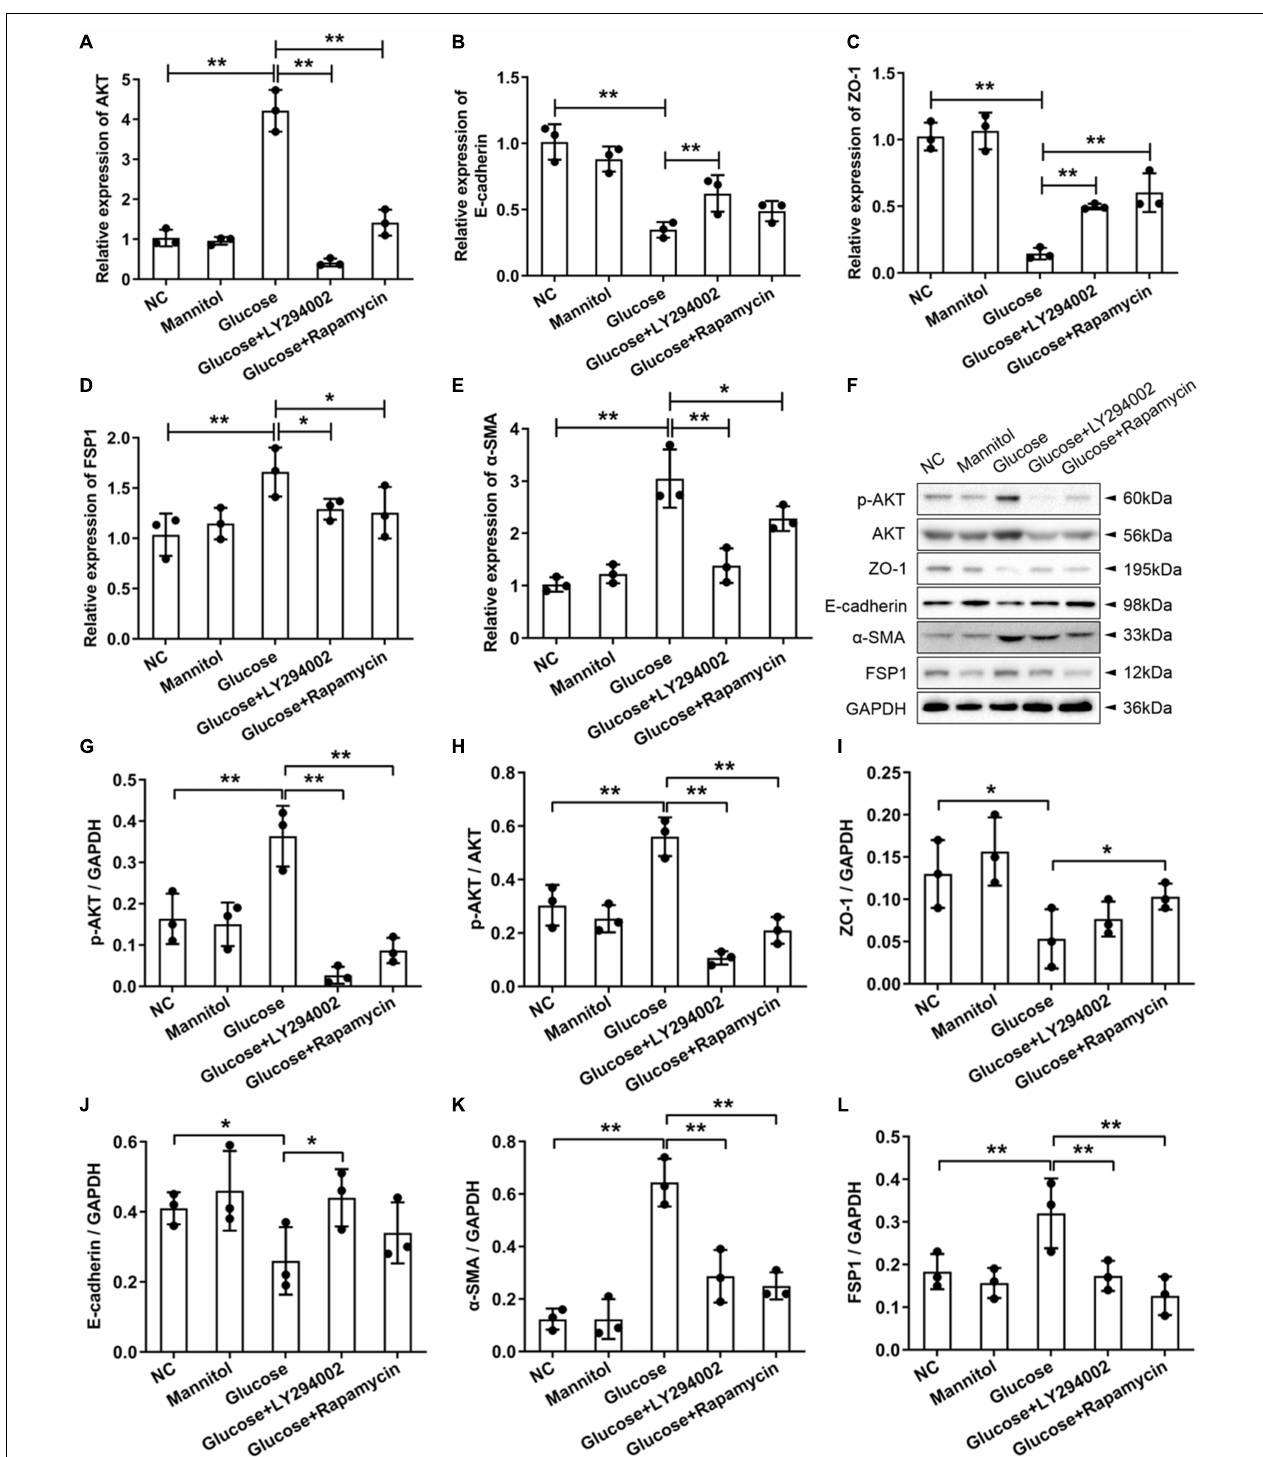
FIGURE 2 | Effects of LY294002 and rapamycin on HG-induced peritoneal fibrosis in vitro . (A–E) The qRT-PCR results showed the expression of AKT, E-cadherin, ZO-1, FSP1, and α -SMA in the HG group, the HG + LY294002 or rapamycin group, and the NC group. (F) The western blot results showed that the protein levels of p-AKT, E-cadherin, ZO-1, FSP1 and α -SMA changed in the HG group and the HG + LY294002 or rapamycin group compared with those in the NC group. (G–K) For the quantitative analysis of p-AKT, E-cadherin, ZO-1, FSP1 and α -SMA protein levels, target protein expression was normalised to that of glyceraldehyde 3-phosphate dehydrogenase (GAPDH). (L) The quantitative analysis of p-AKT protein expression normalised to AKT. Columns represent the means ( n ≥ 3); bars represent the SD; * p < 0.05, ** p < 0.01.